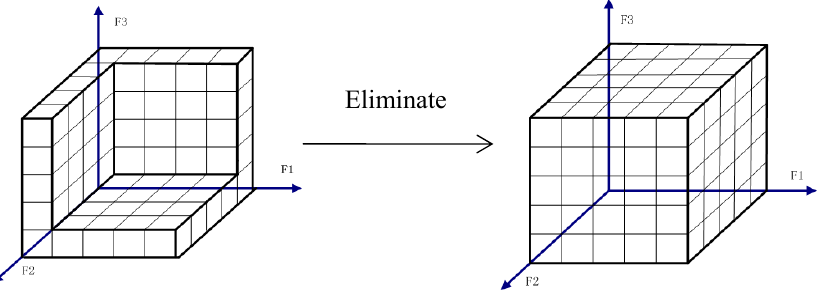
Figure 1. The schematic diagram of iterated elimination of strictly dominant